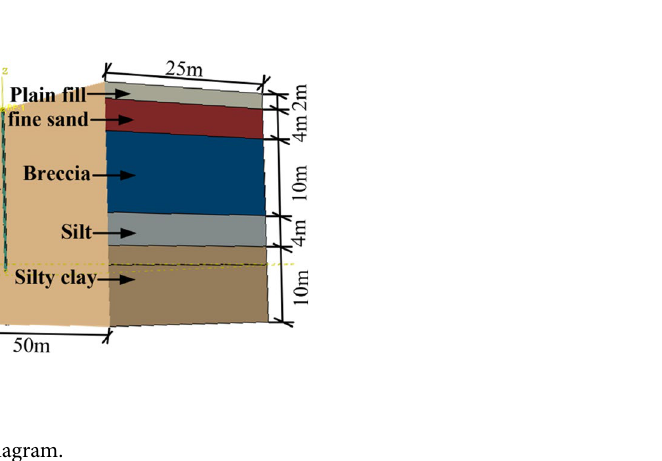
Figure 5. Structural model